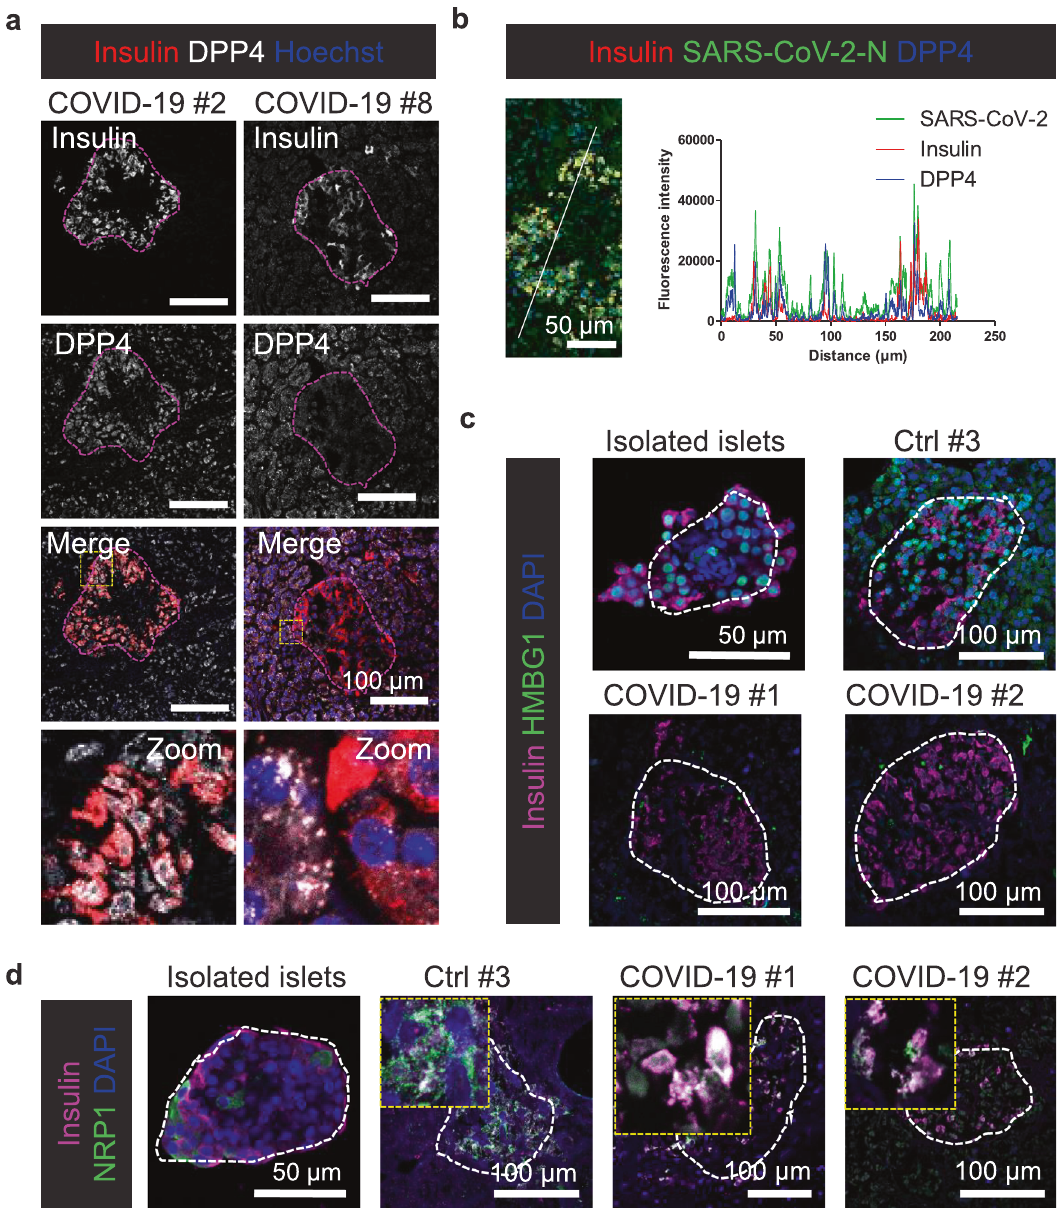
Fig. 3 Alternative receptors and factors potentially facilitating virus entry. a Pancreas sections from control patients and deceased COVID-19 patients were immunostained for insulin to mark beta-cells. Additionally, double stainings for DPP4 were carried out. Representative images from two independent experiments ( n = 2) are shown. Islets are indicated. Scale bars, 100 µ m. b Morphometric analysis of a DPP4/Insulin/SARS-CoV-2-N staining of pancreatic tissue from COVID-19 patient #2 ( n = 1). The fl uorescence intensities in the indicated fl uorescence channels along the white line were measured. Scale bar, 50 µ m. c Double stainings for insulin and HMBG1. Representative images from two independent experiments ( n = 2) are shown. Islets are indicated. Scale bars, 50 µ m for isolated islets, otherwise 100 µ m. d Double stainings for insulin and NRP1. Representative images from two independent experiments ( n = 2) are shown. Islets are indicated. Scale bars, 50 µ m for isolated islets, otherwise 100 µ